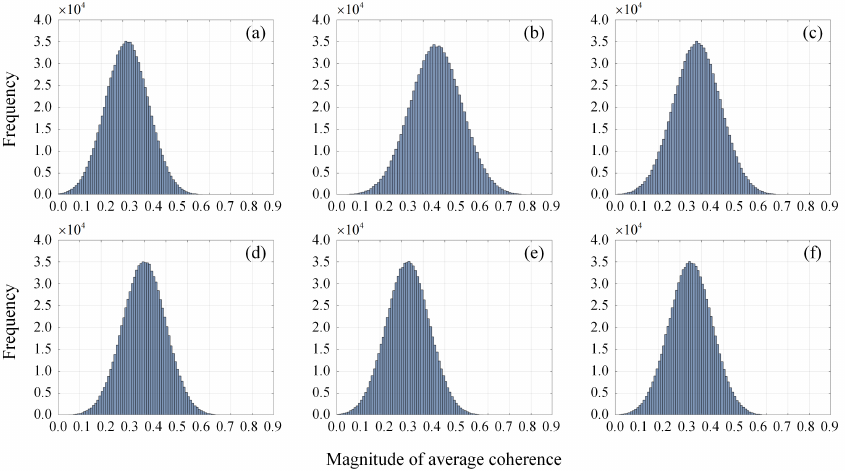
Figure A2. Average coherence histogram: ( a ) 2019 ascending, ( b ) 2020 descending, ( c ) 2021 ascending, ( d ) 2019 descending, ( e ) 2020 ascending, and ( f ) 2021